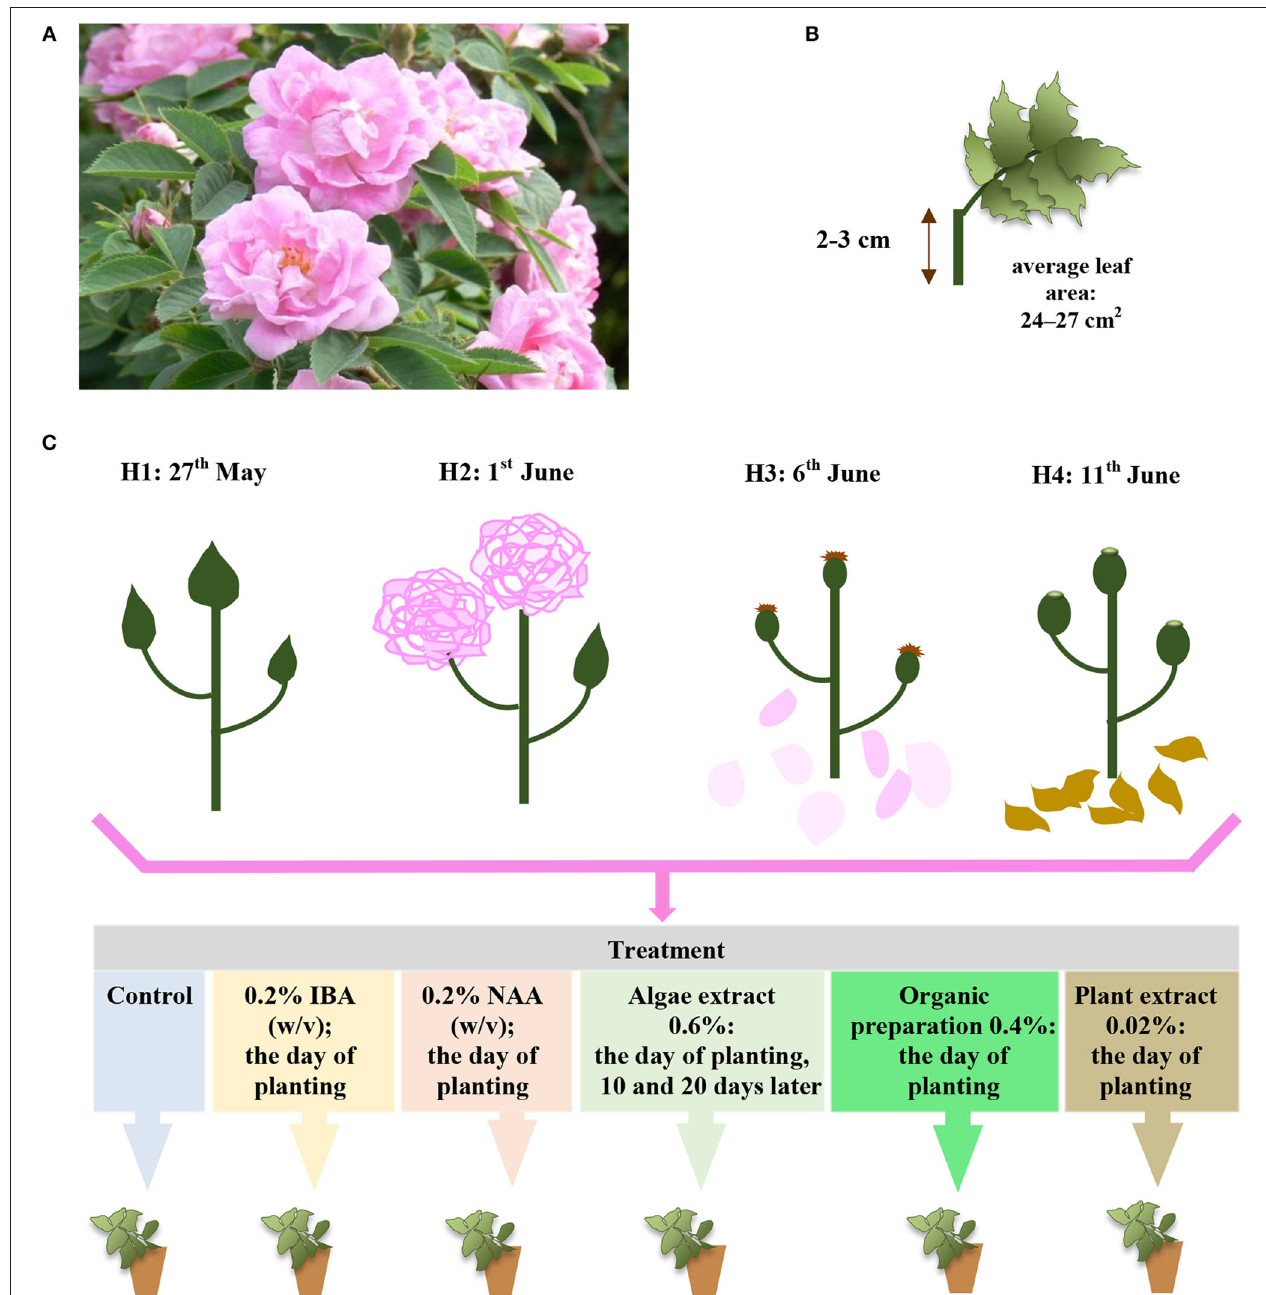
FIGURE 1 | The Rosa “Hurdal” (A) single-node leaf cutting, (B) phenological stages of shoots in terms and their treatment in experiment (C) phenological stages in BBCH scale (Meier et al., 2009): H1 − 54,504 (flower buds still closed); H2 − 69,605 (full flowering; at least 50% of flowers open); H3 − 69,629 (end of flowering of the second-order stem—all petals have fallen); H4 − 70,701 [fruit set: beginning of hip (berry) growth on the main stem].